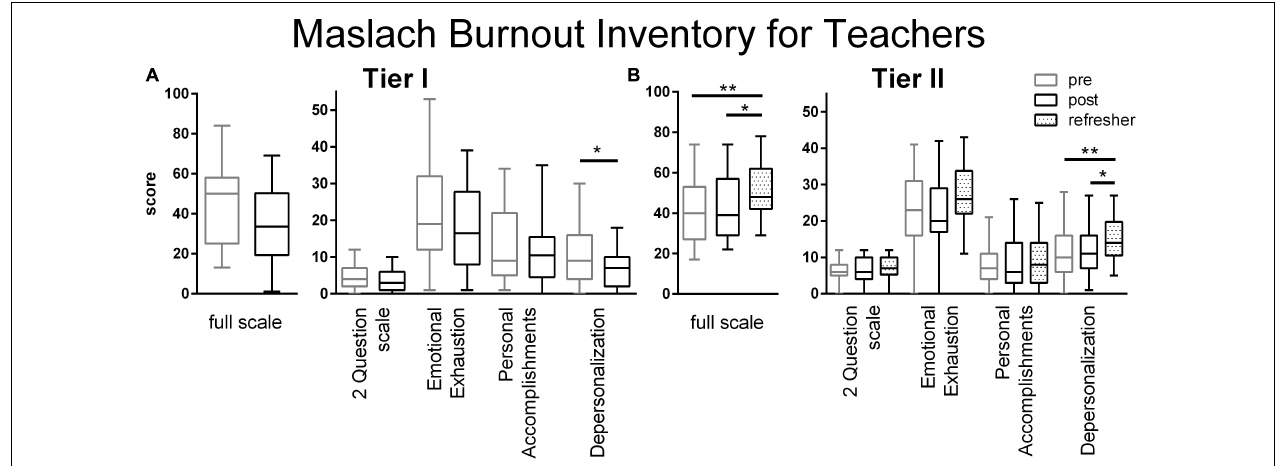
FIGURE 4 | Maslach Burnout Inventory Scale ratings from Tier I (A) and Tier II (B) teachers. Decreases in burn out scores were only observed in Tier I teachers after the training on the Depersonalization subscale ( p = 0.061, full scale; p = 0.269, Two Question Scale; p = 0.141, Emotional Exhaustion Scale; p = 0.457, Personal Accomplishments Scale; p = 0.041, Cohen’s d = –0.61, Depersonalization Scale; two tailed t -test). Among the Tier II teachers, burn out ratings increased by the Refresher (full scale, p = 0.0019, η 2 = 0.088; Two Question Scale, p = 0.437; Emotional Exhaustion Scale, p = 0.0.038, η 2 = 0.047; Personal Accomplishments, p = 0.615; Depersonalization, p = 0.0025, η 2 = 0.085; one way ANOVA with Tukey’s multiple comparison posttest). Boxes represent 25th to 75th percentiles with an internal bar at the median. Whiskers delineate maximum and minimum data points. Tier I N = 23 retrospective pre, 24 post, Tier II N = 43 pre, 39 post, 56 Refresher. For the post tests, *, ** represent p < 0.05, 0.01,